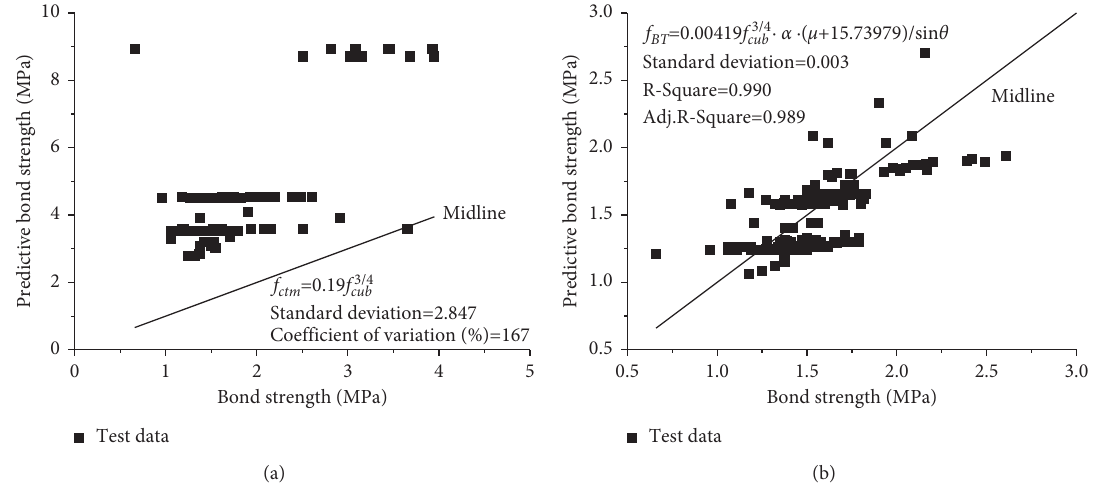
Figure 13: Comparison of experimental values and